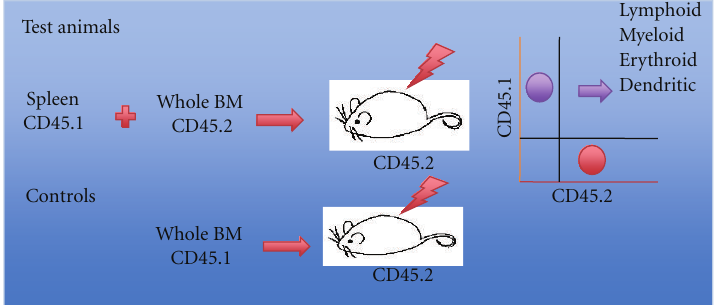
Figure 1: Hematopoietic reconstitution assay for detecting the presence of HSC. The hematopoietic system of lethally irradiated host mice can be fully reconstituted with lymphoid, myeloid, erythroid, and dendritic cells following adoptive transfer of bone marrow cells as a source of HSC. In order to assess the presence of HSC or other hematopoietic progenitors in a test population of cells, CD45-allotype distinct cells are adoptively transferred with assessment of the hematopoietic reconstitution capacity of this specific population by flow cytometry. In most cases, test animals are also given an inoculum of host type bone marrow to ensure survival. HSC with long-term reconstitution potential produce progeny out to 25 weeks, while HSC with short-term potential are assessed after 8 weeks.